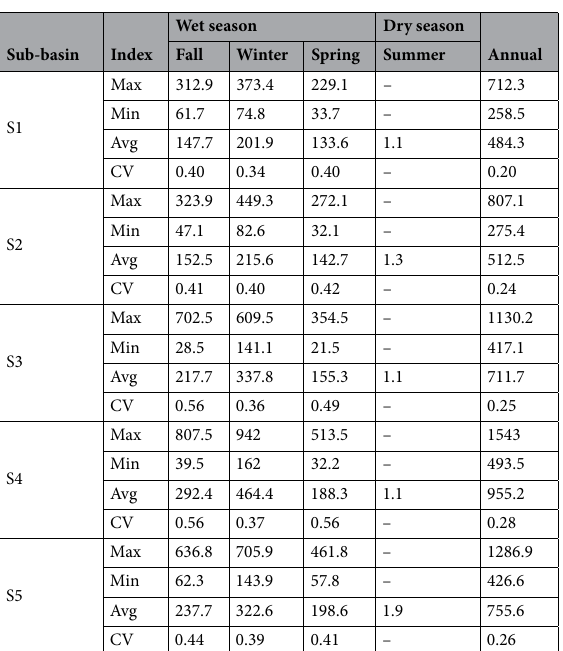
Table 2. Statistical characteristics of annual and seasonal